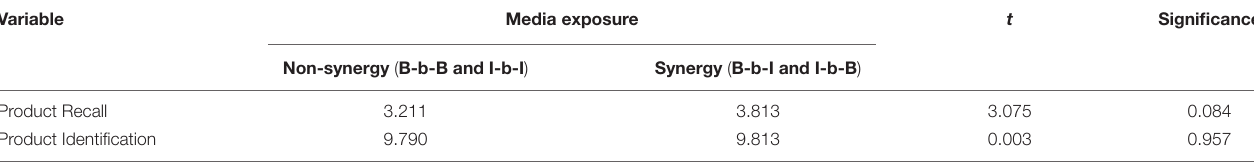
TABLE 5 | Comparison of non-synergistic stimulation and synergistic stimulation in the questioning condition. Variable